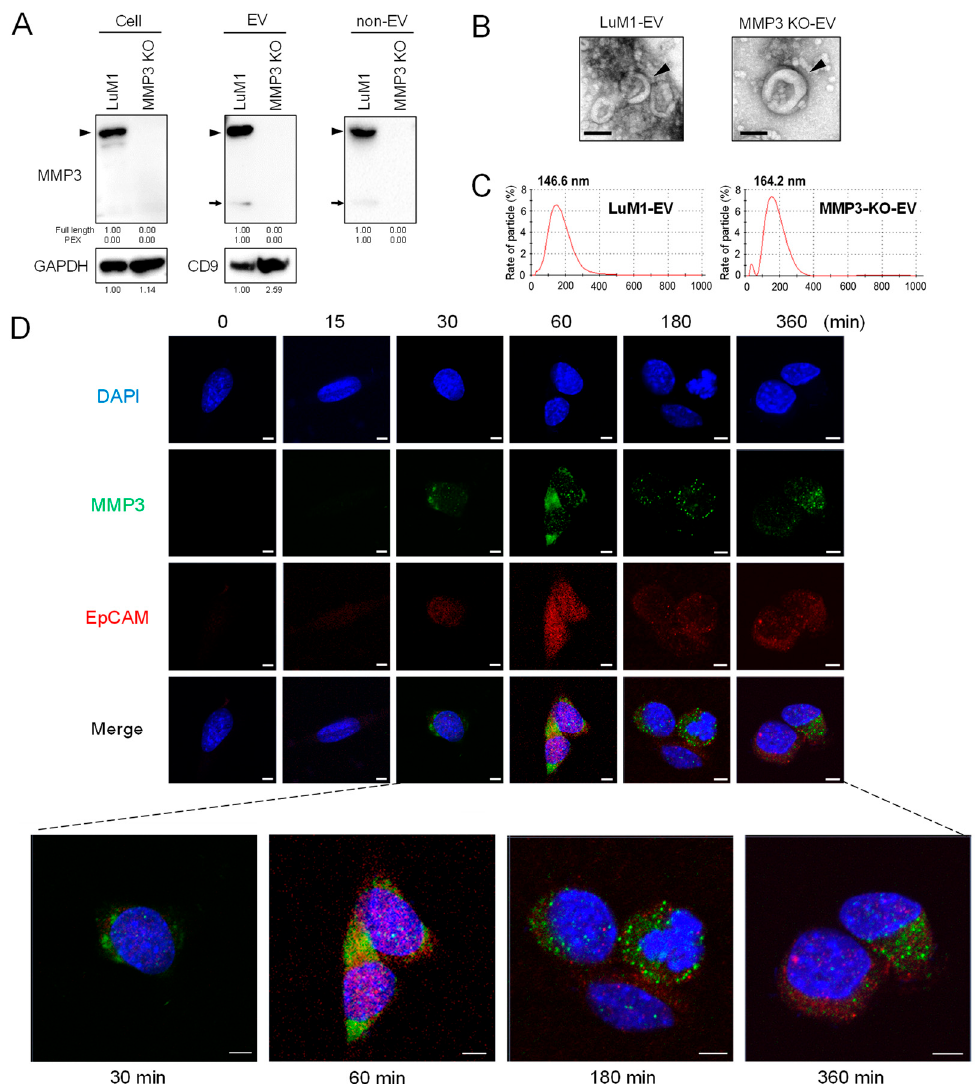
Figure 6. Oncosomal delivery of MMP3 to recipient cells intranuclearly. ( A ) Western blotting of MMP3 Figure 6. and CD9 in cell lysate, EVs and non-EV fractions. Arrowheads indicate full-length MMP3 (54 kDa). Arrows indicate the C-terminal PEX fragment of MMP3. The data of cell lysates were also shown in Figure 3F. ( B ) Representative TEM images of EV fractions derived from LuM1 and MMP3-KO cells. Arrowheads indicate vesicles with cup-shaped morphology. Scale bars, 100 nm. ( C ) Particle diameter distribution of EV fractions. ( D ) Oncosome-mediated intranuclear transfer of MMP3. LuM1-derived, MMP3-rich EVs were added into culture media of MMP3-KO recipient cells at a final concentration of 20 µ g / mL. Cells were fixed at the indicated time points. Immunocytochemistry of MMP3 (green) and CD326 / EpCAM (red) was carried out. Blue, DAPI. The images were taken under CLSM. Scale bars, 5 µ m. The experiments were repeated twice in Figure